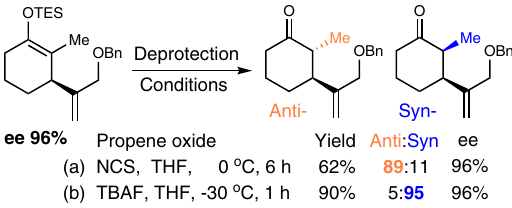
Fig. 6 Chiral α , β -substituted cyclohexanone from 3. Structures were assigned by comparison with literature. a Condition for anti-product preparation. b Condition for syn-product